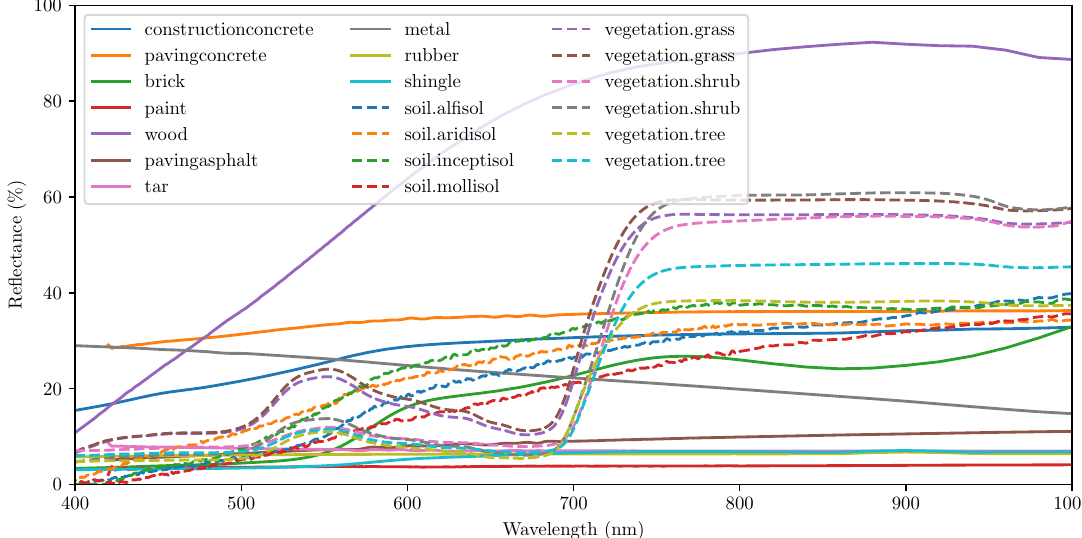
Figure 2. Reflectance of selected samples from the NASA database